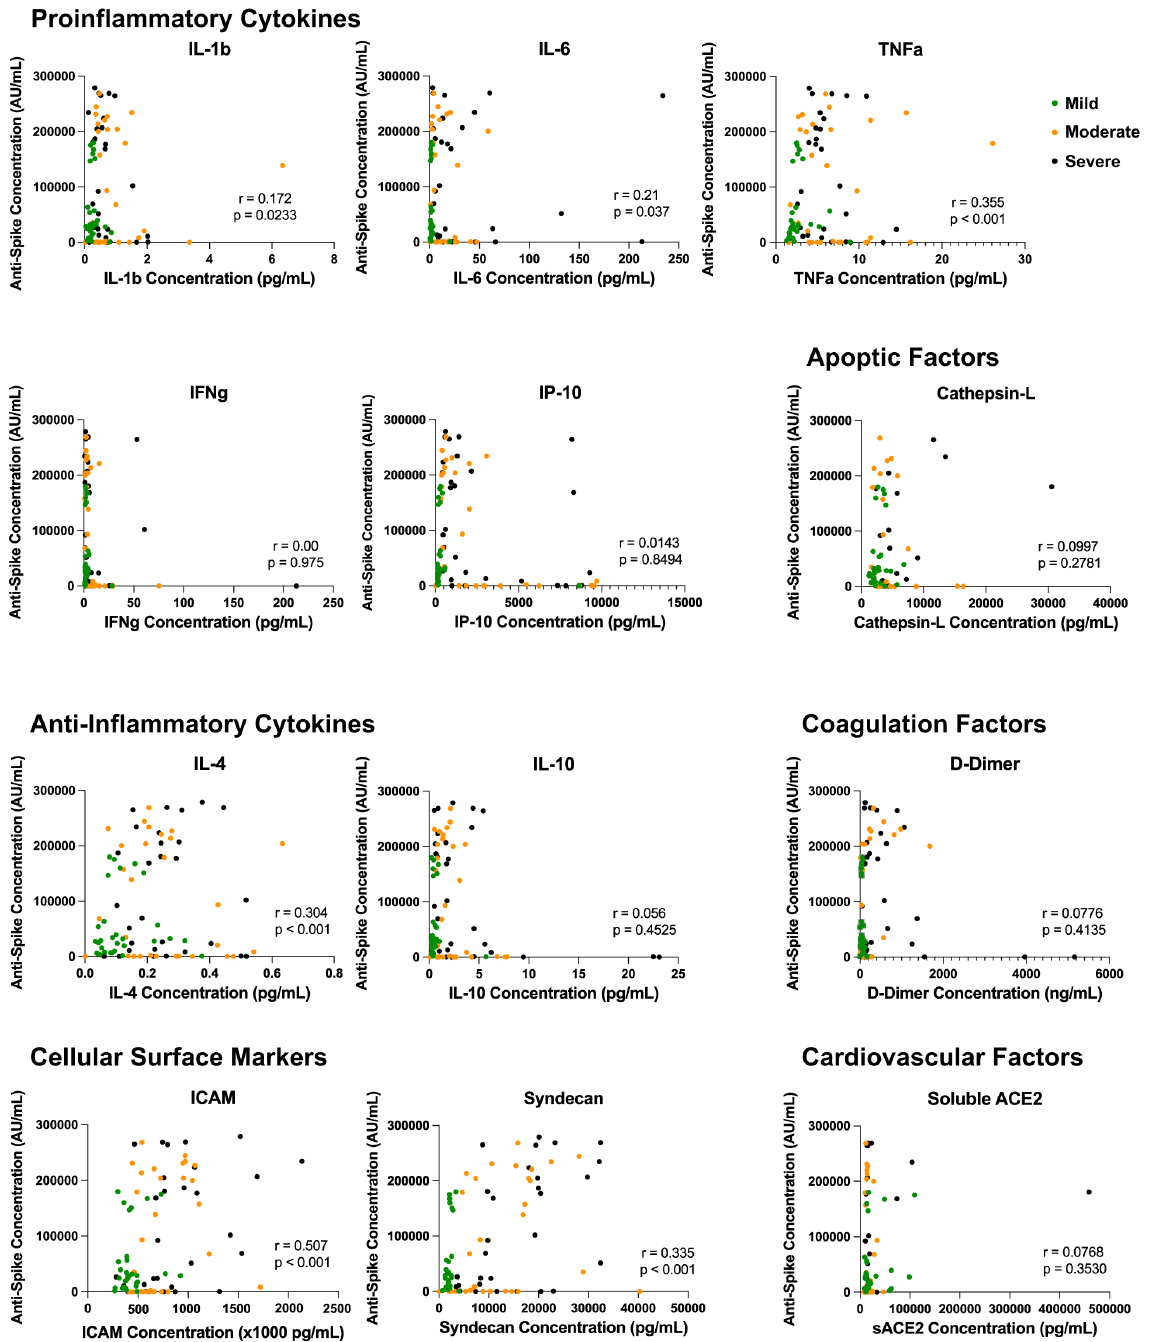
Figure 4. Inflammatory dysregulation between cytokine microenvironment and antibody production. Correlation analysis of inflammatory marker plasma concentration and anti-spike antibody production across disease severity. Across all soluble proinflammatory markers, 6 showed a statistically significant positive correlation between cytokine or epithelial marker and antibody quantity regardless of COVID-19 disease severity, including ICAM ( P < 0.001), IL-1β ( P = 0.0233), IL-4 ( P < 0.001), IL-6 ( P = 0.037), TNFα ( P < 0.001), and Syndecan ( P <